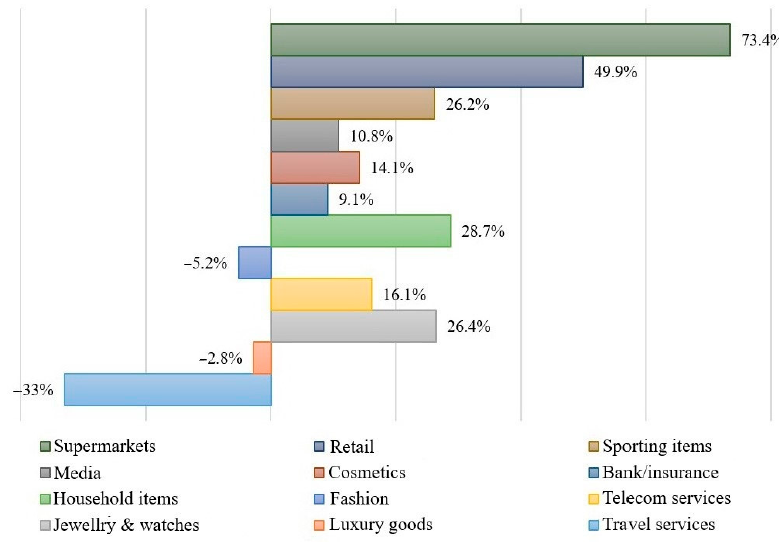
Figure 4. Change in e-commerce transactions by industry. Source: adapted from [49,50]. According to the analysis of survey results, a tendency of consumers to not complete the purchase was 𝜕 = 0.27. Hence, the likelihood of a consumer purchasing a product or a service was 𝑝 ( 𝑄 2) = 1 − 0.27 = 0.73. A summary of raw and normalized RPF factor scores is presented in Table 5. Table 5. Survey findings: raw and normalized factors of a reflexive consumer personality and the Composite Index of Online Purchasing Behavior.